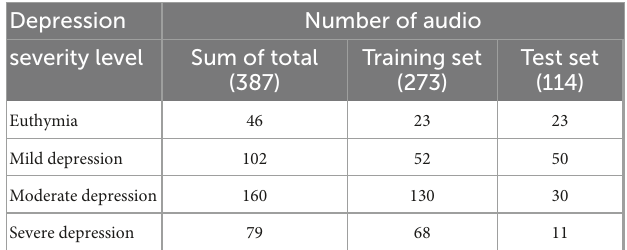
TABLE 1 Distribution of the number of audio data in training set and test